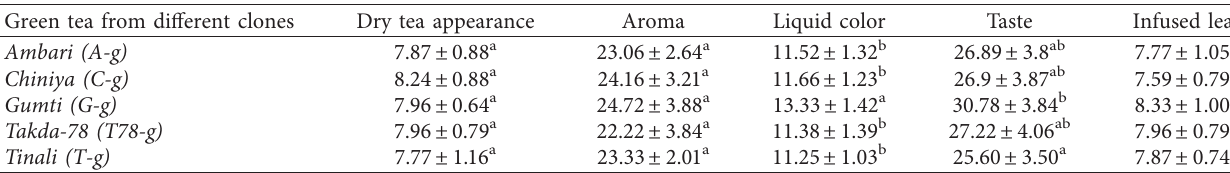
Table 4: Sensory attributes of green tea prepared from different clones of tea plants. Green tea from different clones